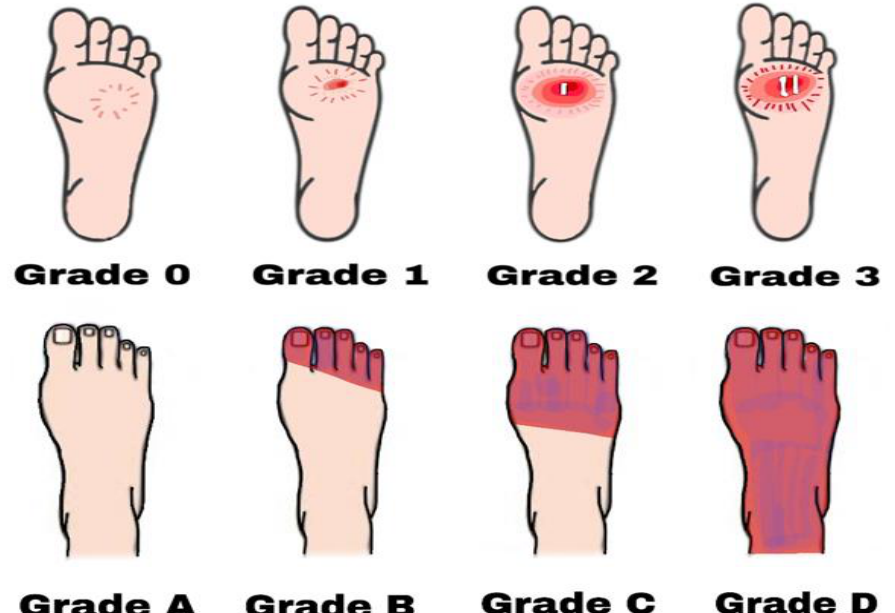
Figure 4. Diabetic foot ulcers based on Brodsky’s classification. Grade 0 has no sign of ulceration but persistent pain is present. Grade 1 is a superficial ulcer. Grade 2 indicates deep ulceration towards the bones. Grade 3 means exposure to severe infection (osteomyelitis). Grade A has no ischemia. Grade B indicates ischemia but no gangrene. Grades C and D are partial and complete gangrene infections with ischemia, respectively.